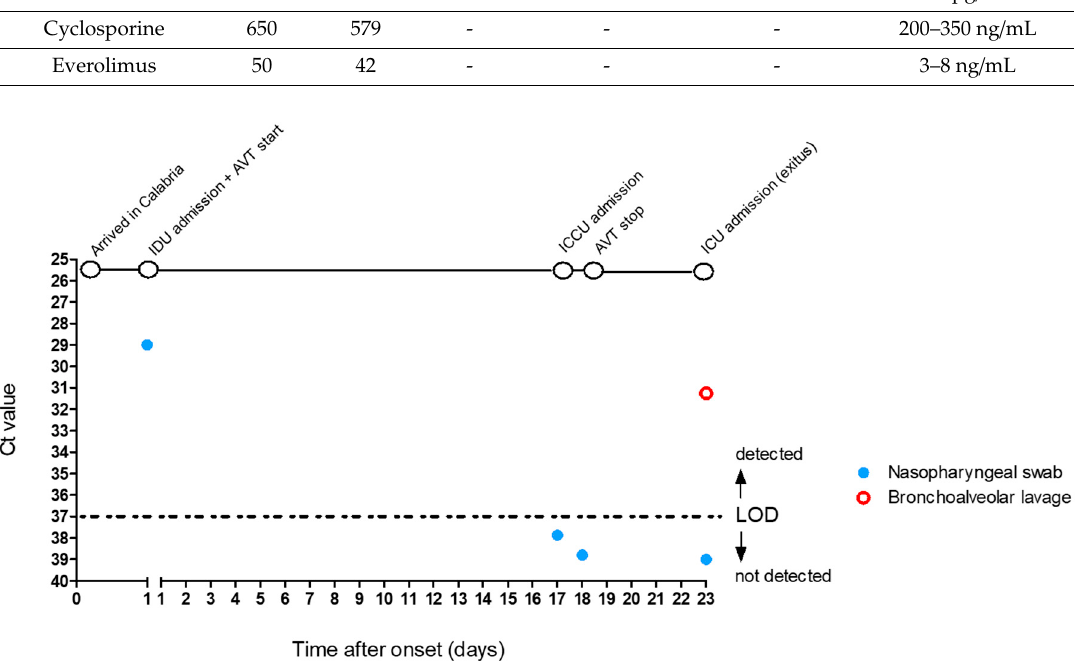
Figure 2. Reverse transcription PCR (RT-PCR): in blue, nasopharyngeal swab. In red, bronchoalveolar lavage. Cycle threshold value (Ct value) 37 Ct is the limit of detection (LOD). Other abbreviations: infectious disease unit (IDU); intensive cardiac care unit (ICCU); antiviral therapy (AVT); intensive care unit (ICU).